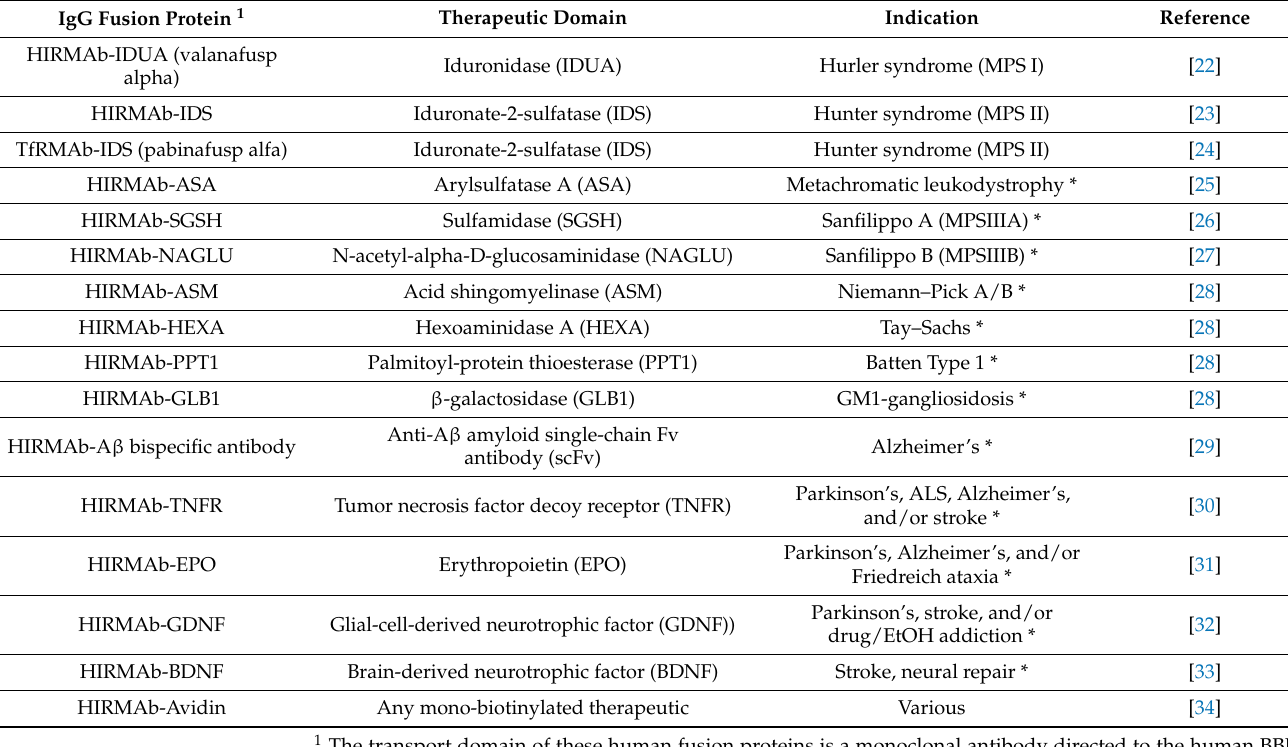
Table 1. Brain-penetrating human IgG fusion proteins.